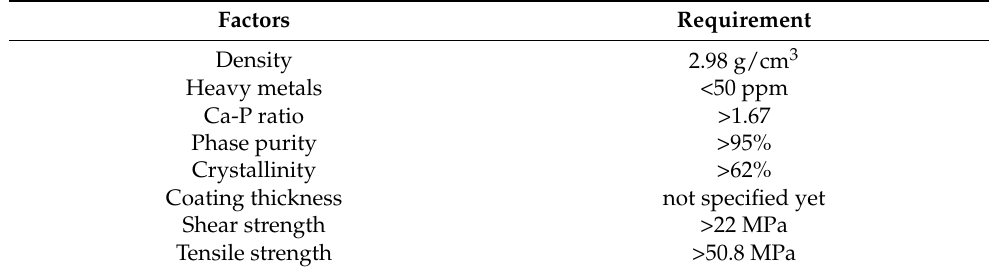
Table 3. HAp coating requirements approved by the food and drug administration (FDA) [11]. Factors Requirement